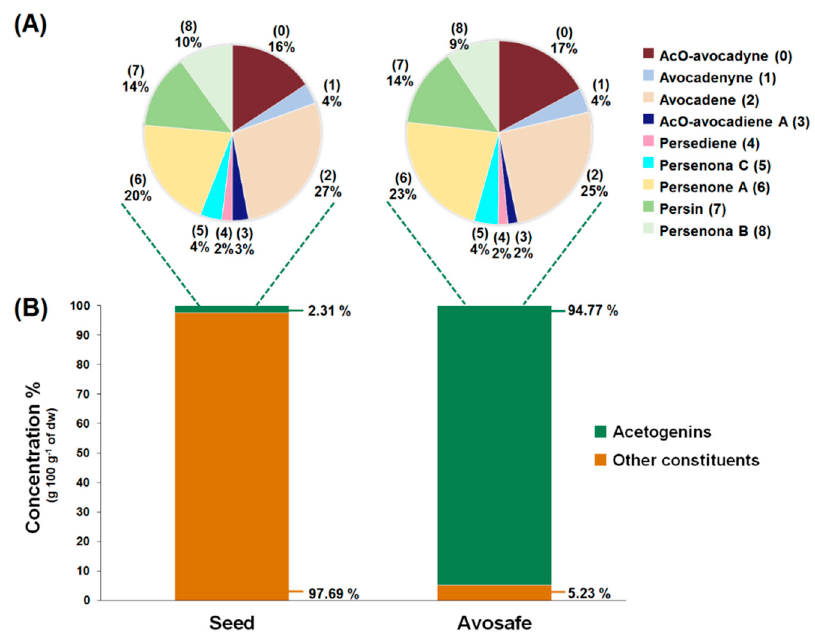
Figure 4. Acetogenin profiles and concentrations (dry weight basis, dw) found in avocado seed ( Persea americana ‘Hass’) and in Avosafe ® , a food-grade acetogenin-enriched extract from avocado seed. ( A ) Shown in pie charts are the chemical profile and relative concentrations of nine acetogenins quantified in avocado seed and Avosafe ® . ( B ) shown in bar charts are the percent contribution of total acetogenin concentrations to the total organic solid composition of avocado seed and of Avosafe ® . Values represent mean ± SD ( n =